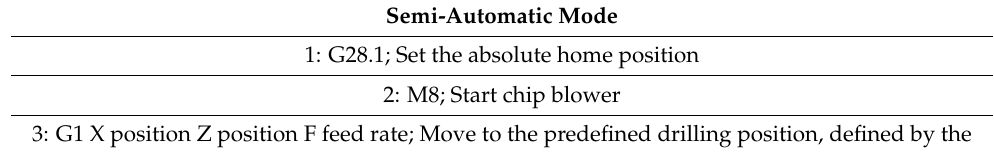
Table 3. Measurement cycle for the semi ‐ automatic operation of the device.